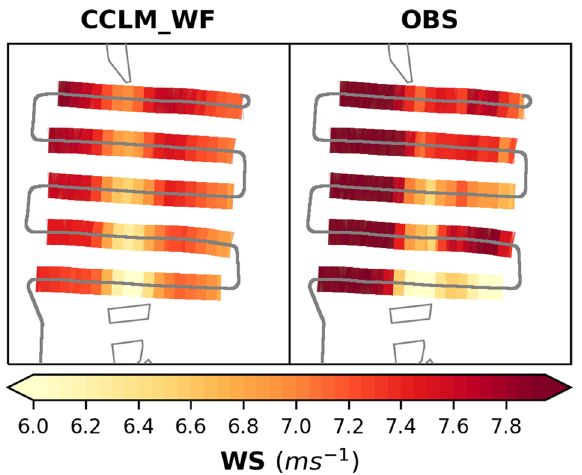
Figure 3. Wind speed at 90 m hub height ( a ) simulated in CCLM_WF and ( b ) observed by aircraft measurements. The aircraft track (gray lines) shown here ranged from 0820 to 0924 UTC on 10 September 2016. The model simulations show the wind speed at 0900